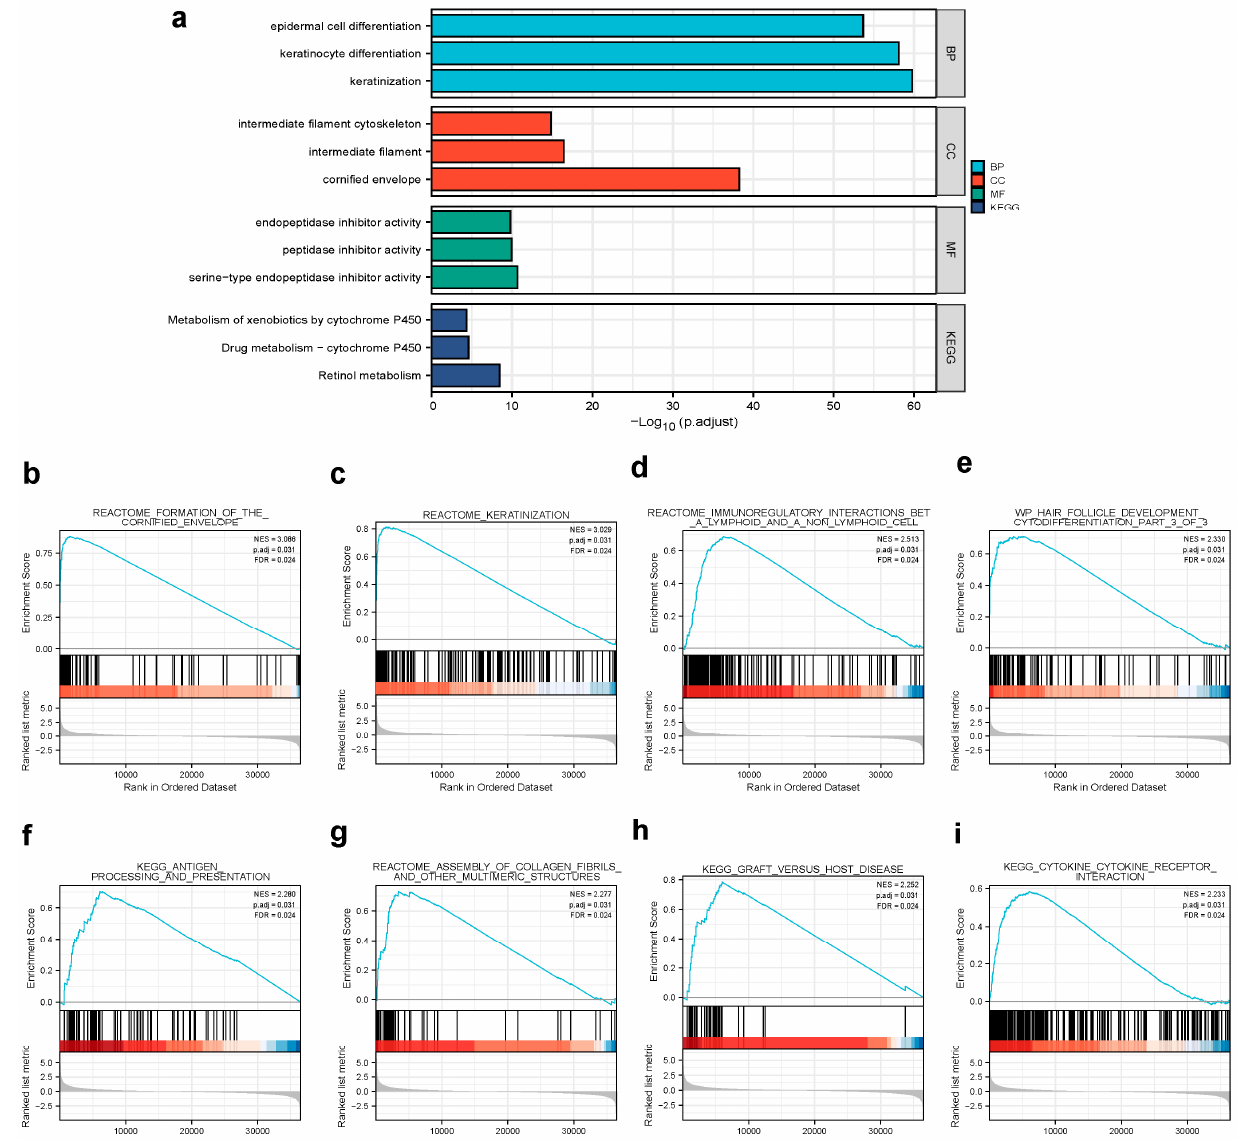
Figure 4. ( a ) GO enrichment analysis of differentially expressed genes (DEGs) in high- and low-CPA4 expression samples; ( b , c ) enrichment plots from GSEA. Several pathways were differentially enriched in BLCA patients according to different CPA4 expressions; ( b ) formation of the cornified envelope; ( c ) keratinization; ( d ) immunoregulatory interactions between a lymphoid and a non-lymphoid cell; ( e ) WP hair follicle development cytodifferentiation part 3 of 3; ( f ) antigen processing and presentation; ( g ) assembly of collagen fibrils and other multimeric structures; ( h ) graft versus host disease; ( i ) cytokine–cytokine receptor interaction. ES, enrichment score; NES, normalized enrichment score; ADJ p -Val, adjusted p -value; FDR, false discovery rate.